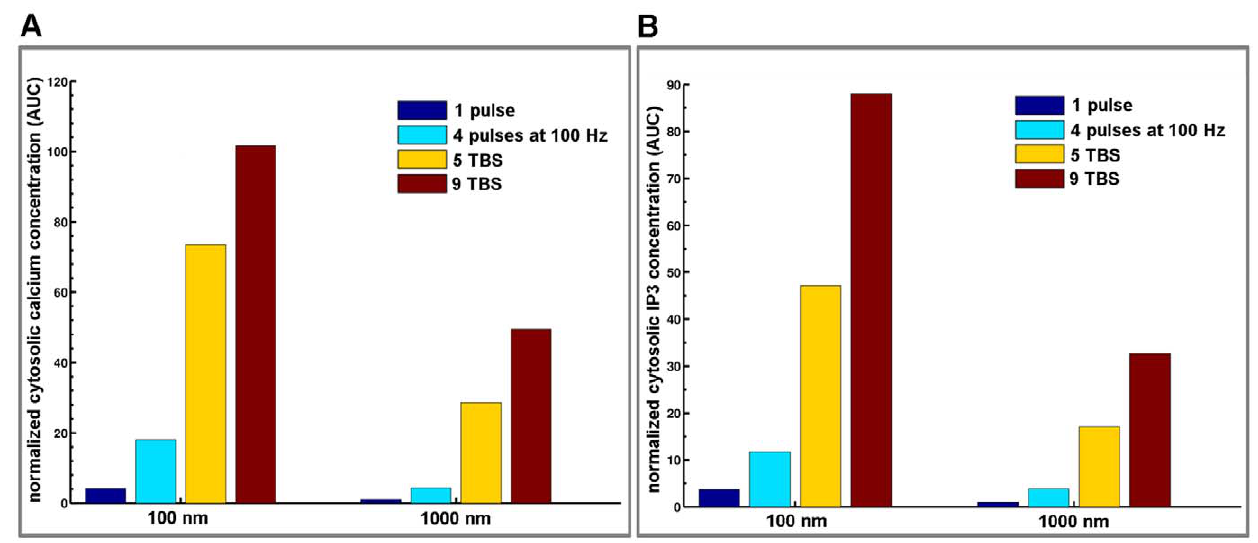
Figure 6. Effects of stimulation patterns and receptor location on integrated calcium and IP3 dynamics. (A) Histograms represent quantification of the area under the curve (AUC) for mGluRI-mediated calcium dynamics with various stimulation patterns and receptors located at 100 nm and 1000 nm from the release site. (B) Corresponding histograms of the AUC for mGluRI-mediated IP3 dynamics with various stimulation patterns and receptors located at 100 nm and 1000 nm from the release site. AUC values were normalized to the AUC value calculated for one release event with mGluRI located at 1000 nm from the release site.